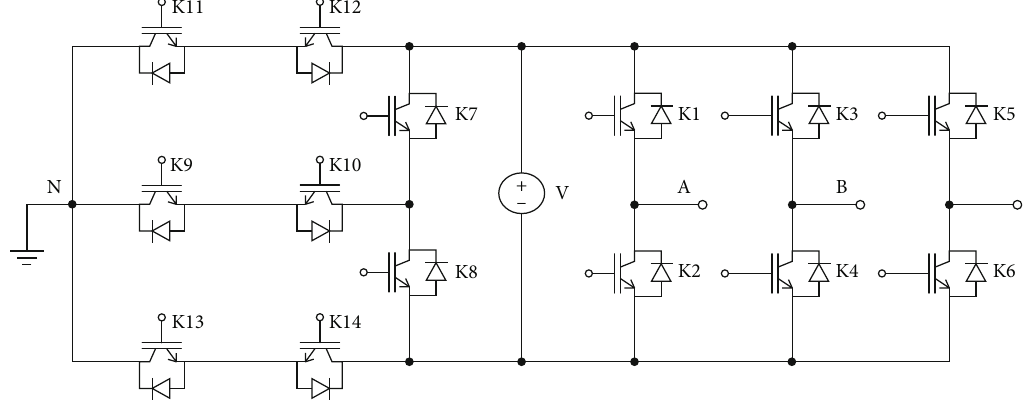
Figure 2: Three-phase, fi ve-level multicellular model (5 L – SMC H-bridge)